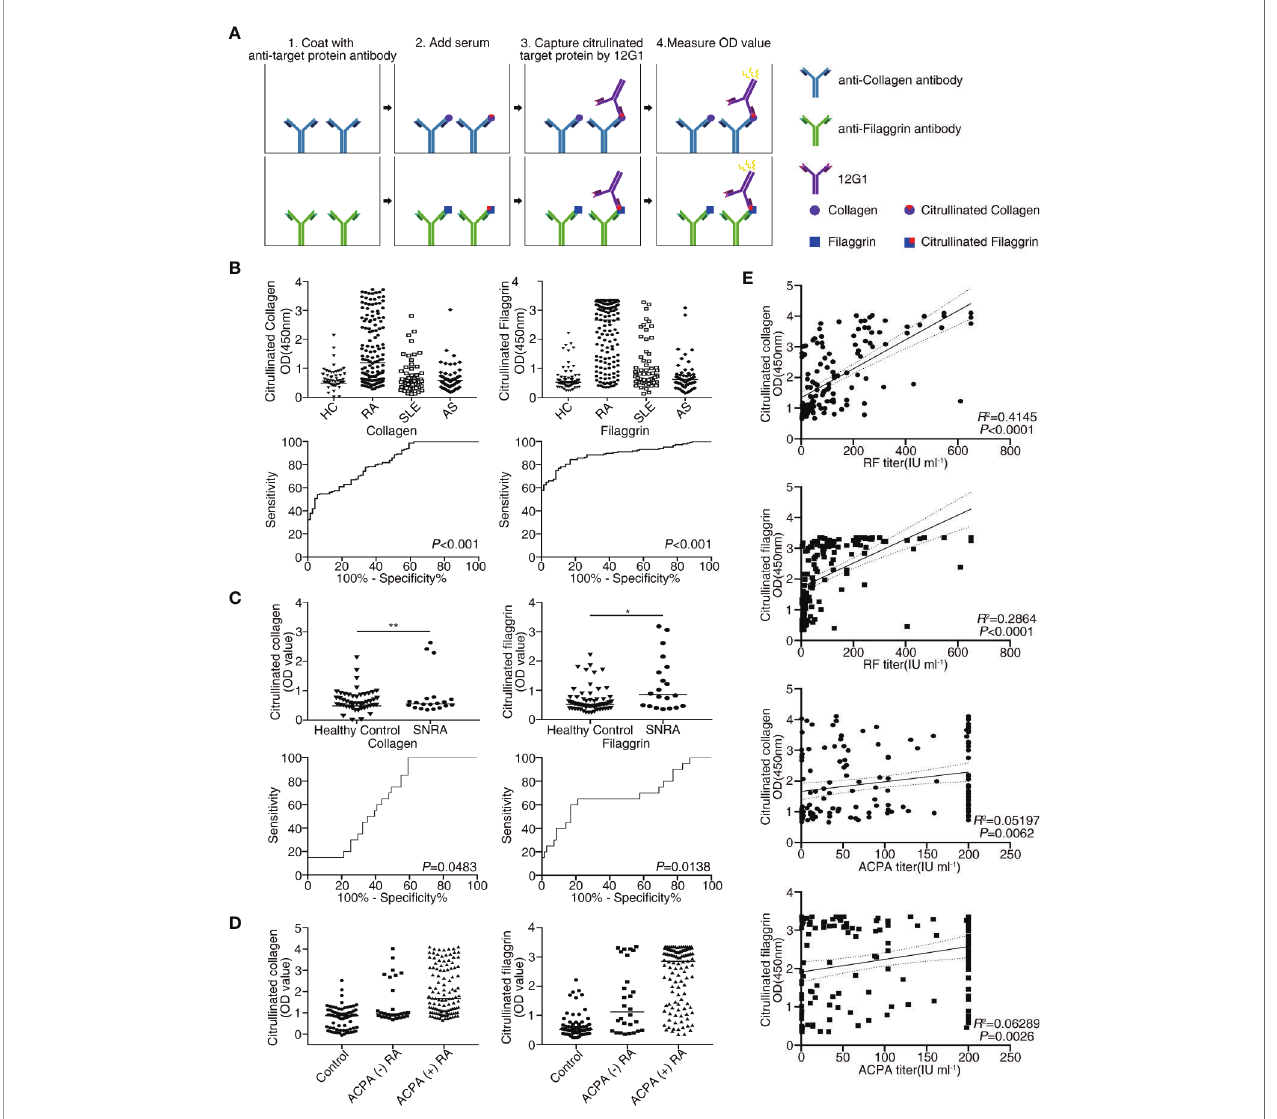
FIGURE 3 | Receiver operating characteristic (ROC) curve analysis comparing the sensitivity and speci fi city of the ELISA for measuring the levels of citrullinated collagen, and citrullinated fi laggrin in patient serum. Anti-collagen, and anti- fi laggrin were coated onto plates to capture the candidate antigens. Citrullination was detected by the 12G1. (A) Schematic diagram showing the method for the sandwich ELISA using an anti-target protein antibody and 12G1. (B) Circulating citrullinated antigens in serum samples from RA (n = 148), SLE (n = 60), AS (n = 57) patients and control subjects (n = 71) (upper row) and the ROC curve for each target antigen (lower row). (C) Circulating citrullinated antigens in the sera of seronegative RA (n = 20) and control subjects (n = 71) (upper row) and the ROC curve for each target antigen (lower row). Speci fi city (true negative rate [the percentage of RA patients correctly predicted]) is plotted on the x-axis, and sensitivity (the percentage of RA patients correctly predicted) is plotted on the y-axis. Calculations were based on the predicted probability of each subject being above the cutoff OD values. P values were calculated using the Mann-Whitney U test. * P < 0.05. (D) OD values of three circulating citrullinated autoantigens for the control, ACPA- negative RA, and ACPA-positive RA subjects. (E) Correlations between circulating citrullinated collagen and fi laggrin OD values and RF titers (n =146, r =0.644 for collagen, r = 0.535 for fi laggrin, P < 0.0001), and ACPA titers (n = 143, r = 0.228 for collagen, r = 0.251 for fi laggrin, P < 0.01) in RA patients (Pearson ’ s correlation coef fi cient). **P <